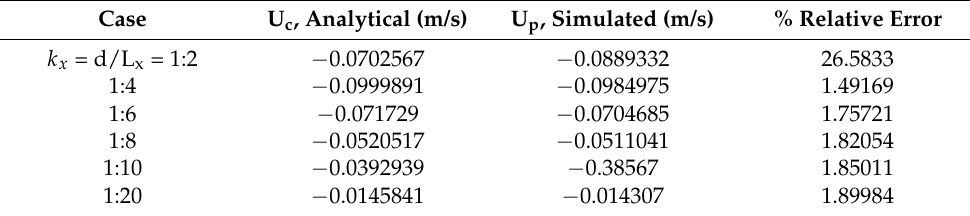
Table A2. Effect of the ratio k = d/L x